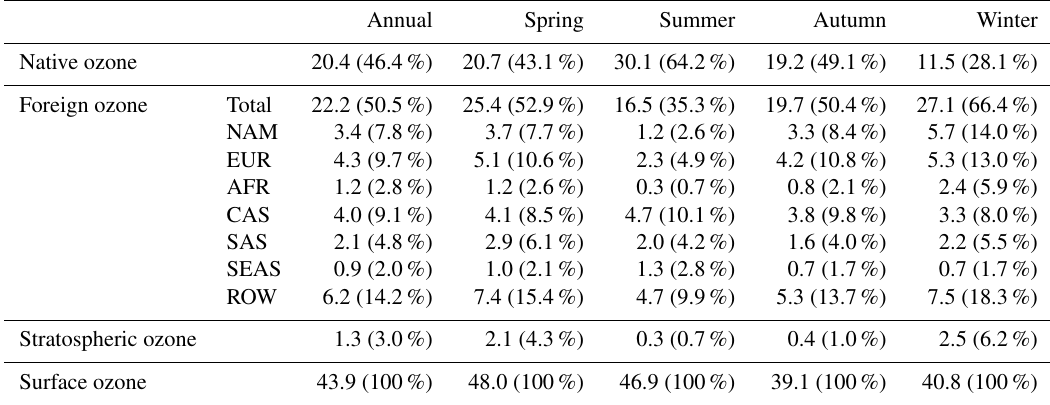
∗ All values are the means over East Asia. The abbreviations stand for different regions (Fig. 1): Asia (EAS), North America (NAM), Europe (EUR), Africa (AFR), central Asia (CAS), South Asia (SAS), South-east Asia (SEAS), and the rest of the world (ROW). Total foreign ozone is the sum of the contributions from all foreign